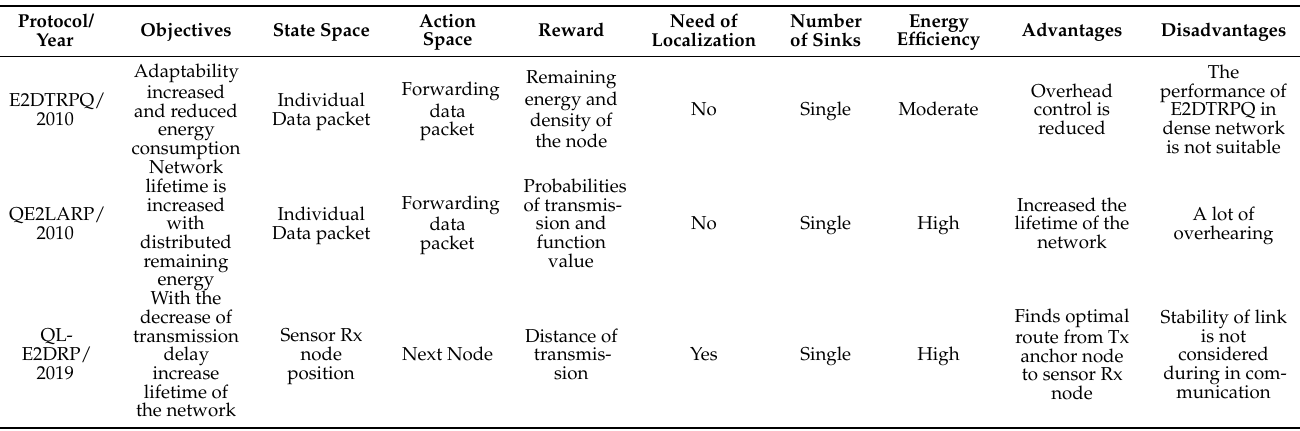
Table 11. Comparison of RL-based